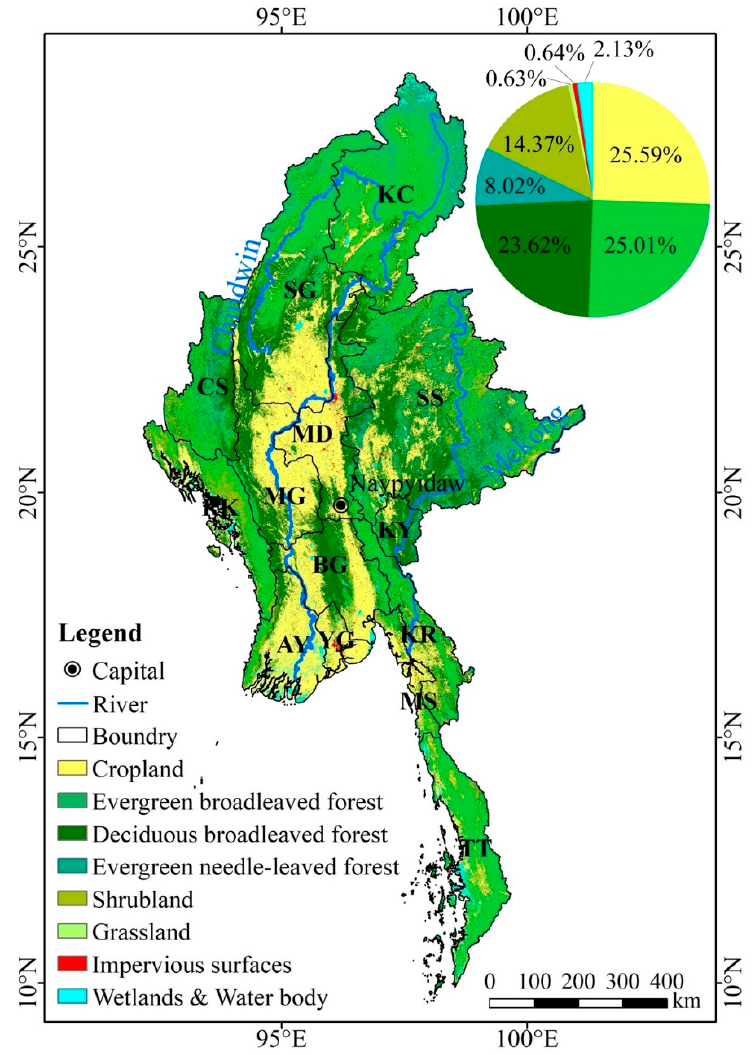
Figure 2. LUC map of Myanmar in 2020.